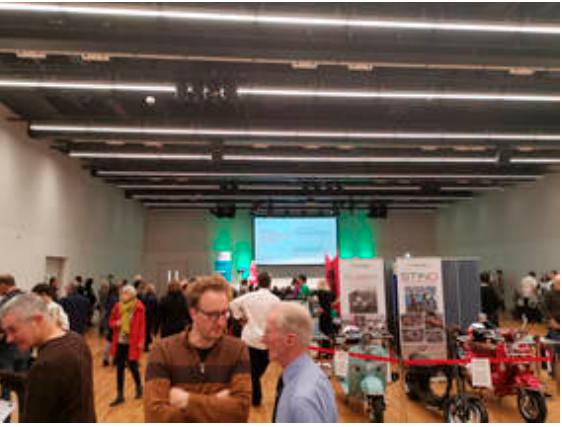
Figure 6. Stalls and visitors at Carbon Neutral 2030 Launch event, 18 January 2020 @UNA East ‐ bourne.